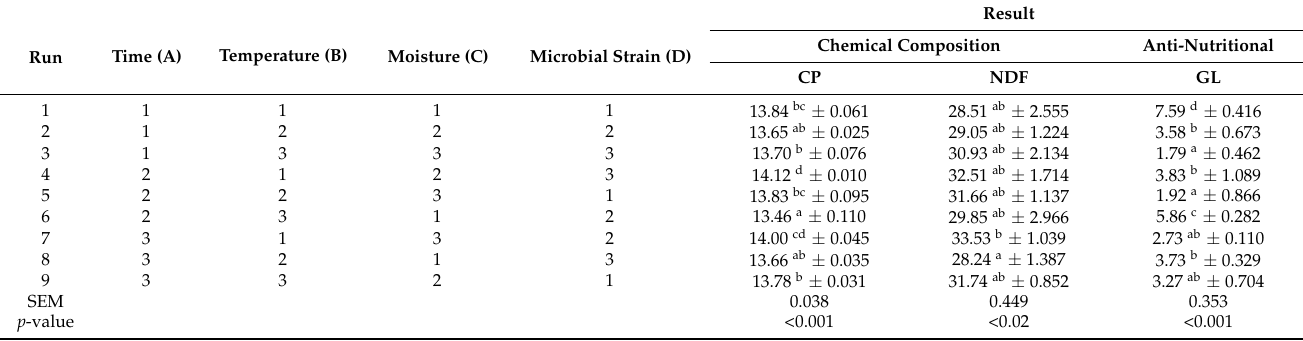
Table 10. Orthogonal results of fermentation test with multi factors of TMR with